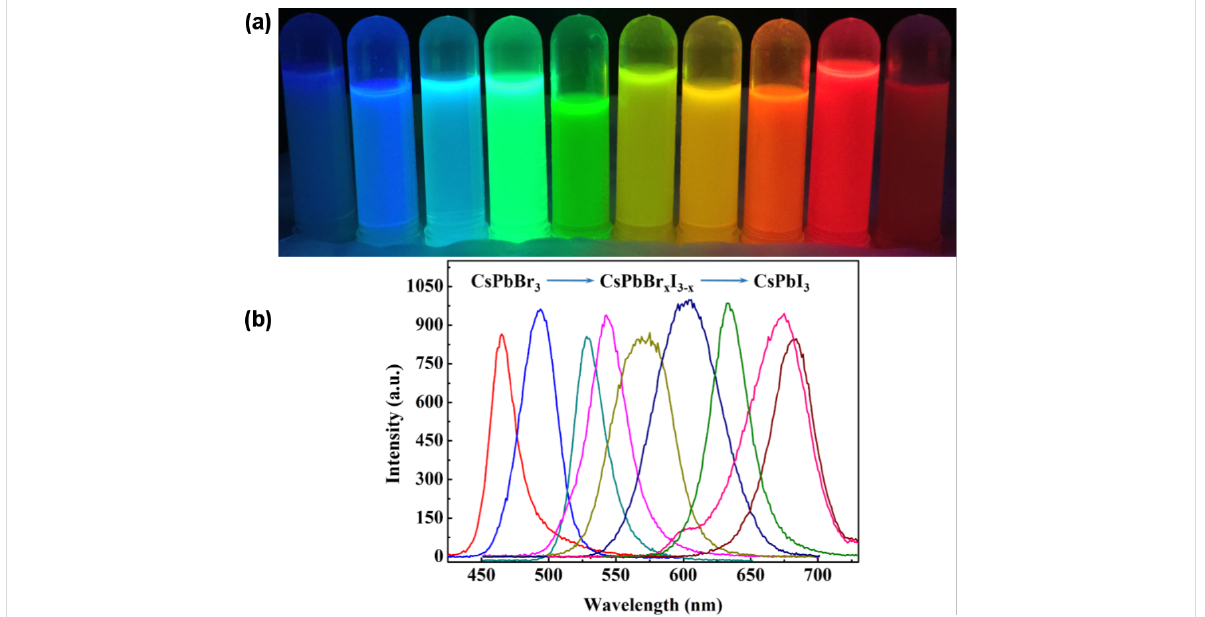
Figure 1: (a) Color luminescence under ultraviolet light and (b) photoluminescence of CsPbX 3 quantum dot solutions.